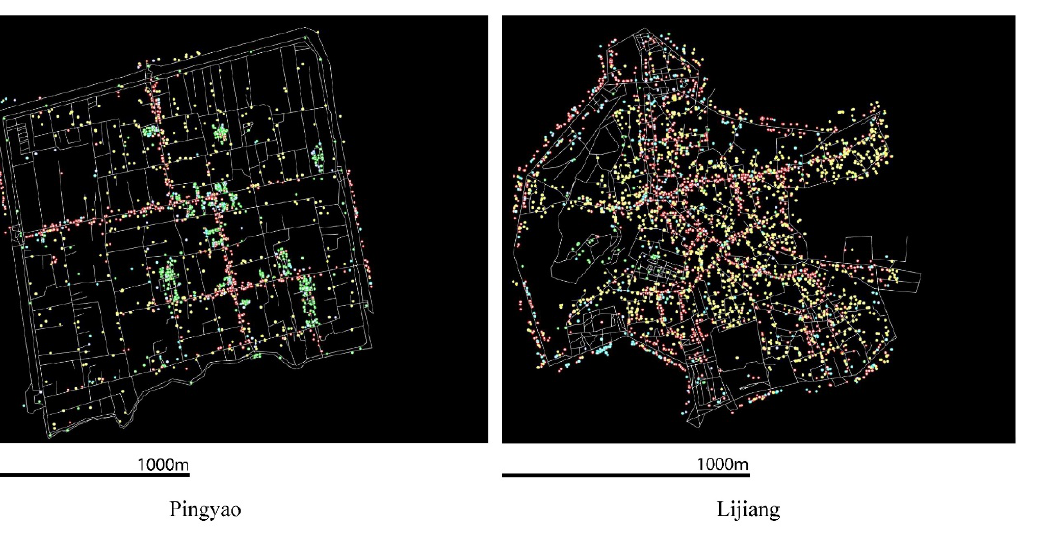
Figure 8. POI distribution in the four HCTs.